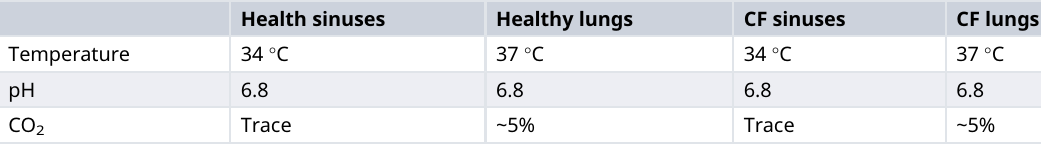
Table 13. Incubation conditions for each developed